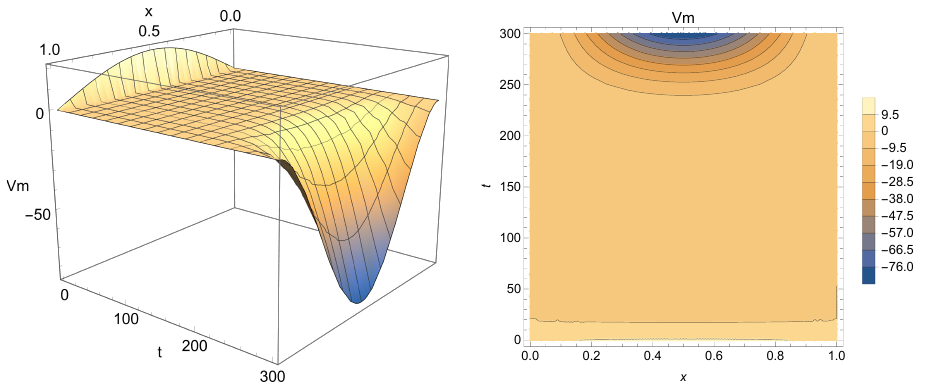
Figure 6. One-dimensional nonhomogeneous solution describing repolarization after the potential plateau: Equation (18) with α = 0.5.